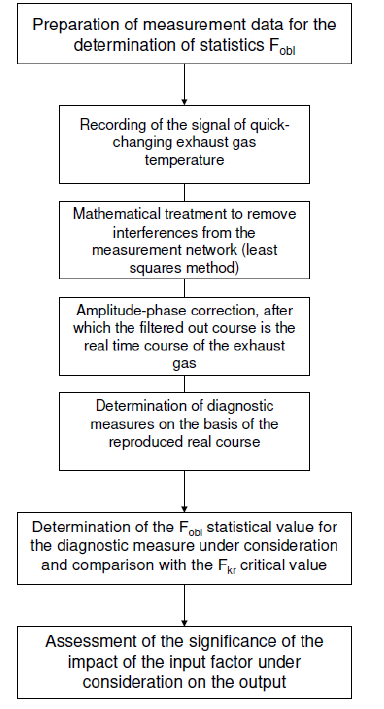
Fig. 2. Stages of preparation of measurement data for determination of Fisher-Snedecor statistic F decomposition for diagnostic purposes